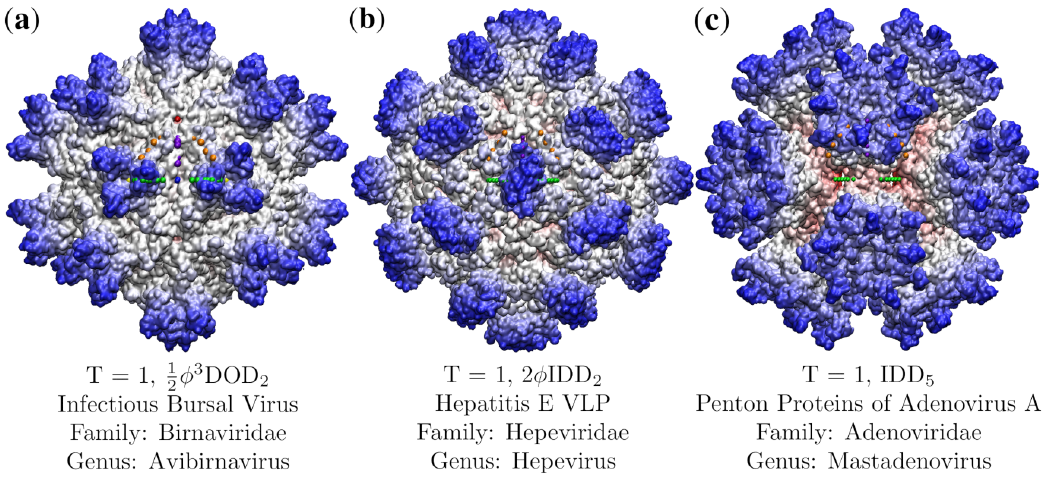
Figure 2. A structural comparison showing the wide diversity in viral capsid shapes of even the simplest T = 1 viruses. Each virus capsid has been radially colored, with red being the most interior, and blue the exterior. These three, ( a ) Infectious Bursal Virus (Avibirnavirus, 2gsy [18]), ( b ) Hepatitis E Virus-like particle (Hepevirus, 3hag [19]), and ( c ) Penton Base of Adenovirus A (Mastadenovirus, 4aqq [20]), were chosen as they have almost no overlap in their protruding features. The best fit point array for each capsid is listed. We will see that these point arrays describe unique features and complement the T -number classification. The asymmetric unit of each capsid is contained by the triangular region of gauge points (Figure